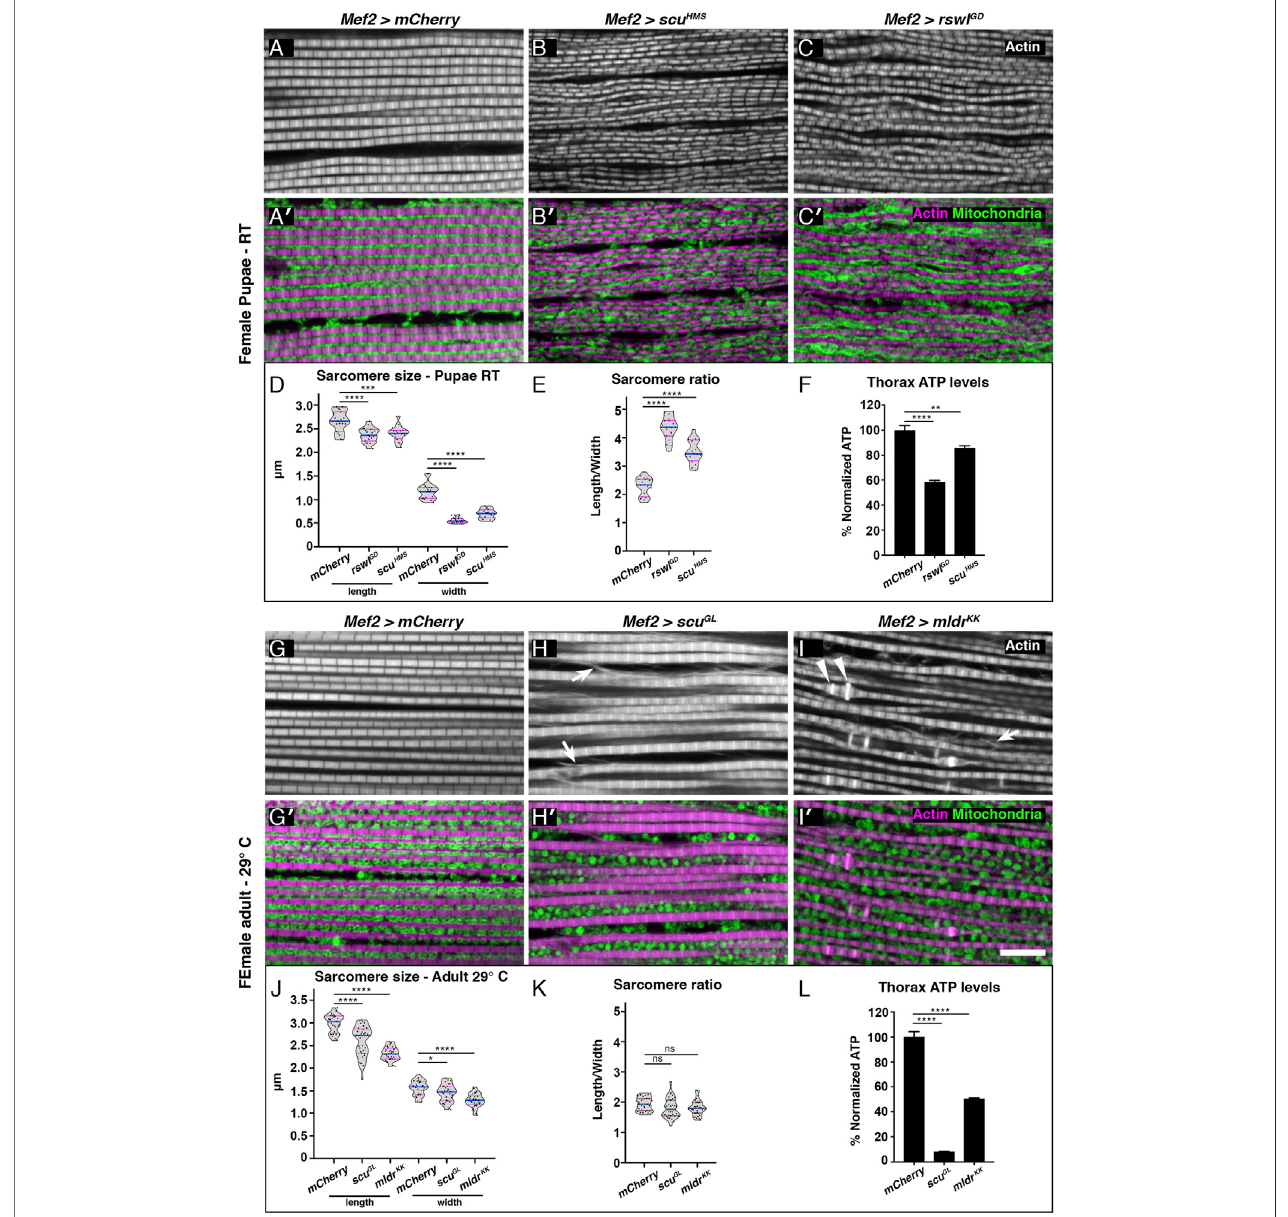
FIGURE 3 | Reduction of mtRNase P subunits in skeletal muscle causes smaller sarcomeres, and myo fi brillar disorganization and disrupts mitochondrial morphology. (A – C 9 ) Confocalmicroscopymicrographsofthoracicskeletalmuscleisolatedfromfemalepupaegrownatroomtemperature(RT). Mef2 > mCherry control muscle exhibits a regular sarcomere pattern [ (A) , white, (A 9 ) , magenta] and mitochondria are tightly packed and regularly spaced between the myo fi brils [ (A 9 ) , green]. Mef2 > scu HMS andMef2 > rswl GD pupaehavedisorganizedmyo fi brils[ (B,C) ,white]andmitochondriaarenotevenlydistributedbetweenthemyo fi brilsnorregularly shapedcomparedtocontrol[ (B 9 ,C 9 ) ,greenvs. (A,A 9 ) ]. (D) Mef2 > scu HMS and rswl GD pupaehaveshorter,thinnersarcomerescomparedto mCherry controlresultingin a larger length/width ratio (E, F) ATP levels in isolated thoraces from female pupae grown at RT. (G – I 9 ) Skeletal muscle isolated from adult females grown at 29 ° C. (G) Mef2 > mCherry control muscle exhibits a regular sarcomere pattern [ (G) , white, (G 9 ) , magenta] and mitochondria are evenly distributed between the myo fi brils and are uniform in size and shape [ (G 9 ) , green]. Mef2 > scu GL and Mef2 > mldr KK adults have disorganized myo fi brils [ (H,I) , white] that exhibit actin abnormalities (arrows, arrowheads). In addition, mitochondria are less tightly packed (H 9 ,I 9 ) and not evenly distributed between the myo fi brils (H 9 ,I 9 ) compared to control (A,A 9 ) . (J) Mef2 > scu GL and Mef2 > mldr KK adults have shorter, thinner sarcomeres compared to mCherry control but retain the same length/width ratio as control (K) . (L) ATP levels in isolatedthoracesfromadultsgrownat29 ° C.Actin=white (A – C,G – I) ,magenta (A 9 -C 9 ,G 9 -I 9 ) .anti-ATPsynthase=green (A 9 -C 9 ,G 9 -I 9 ) . (D,E,J,K) Eachpointontheviolin plot represents an average of 20 measurements of one muscle from eight to ten different animals per genotype. The median and quartiles are represented by blue and magenta horizontal solid lines, respectively. Further description can be found in the materials and methods. Error bars = standard deviation. Statistical signi fi cance was calculatedwithGraphPad Prismusing atwo-tailedt-test comparing Mef2 > mCherry controlRNAitoeach experimentalRNAitocalculate p values. * = p < 0.05, ** = p < 0.01, *** = p < 0.001, **** = p < 0.0001. Graphs were plotted using GraphPad Prism. Scale bar = 10 μ m in (I 9 ) for (A – C 9 ) and (G – I 9 ) .